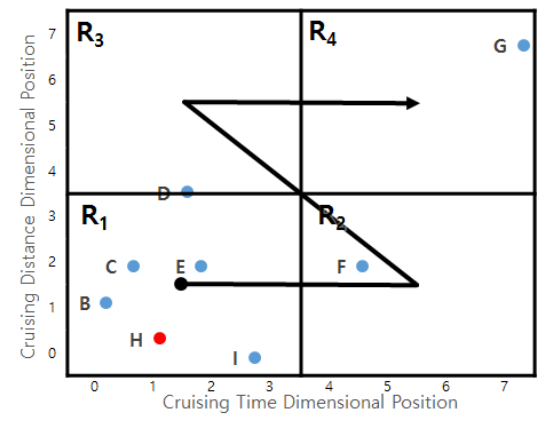
Figure 19. A region